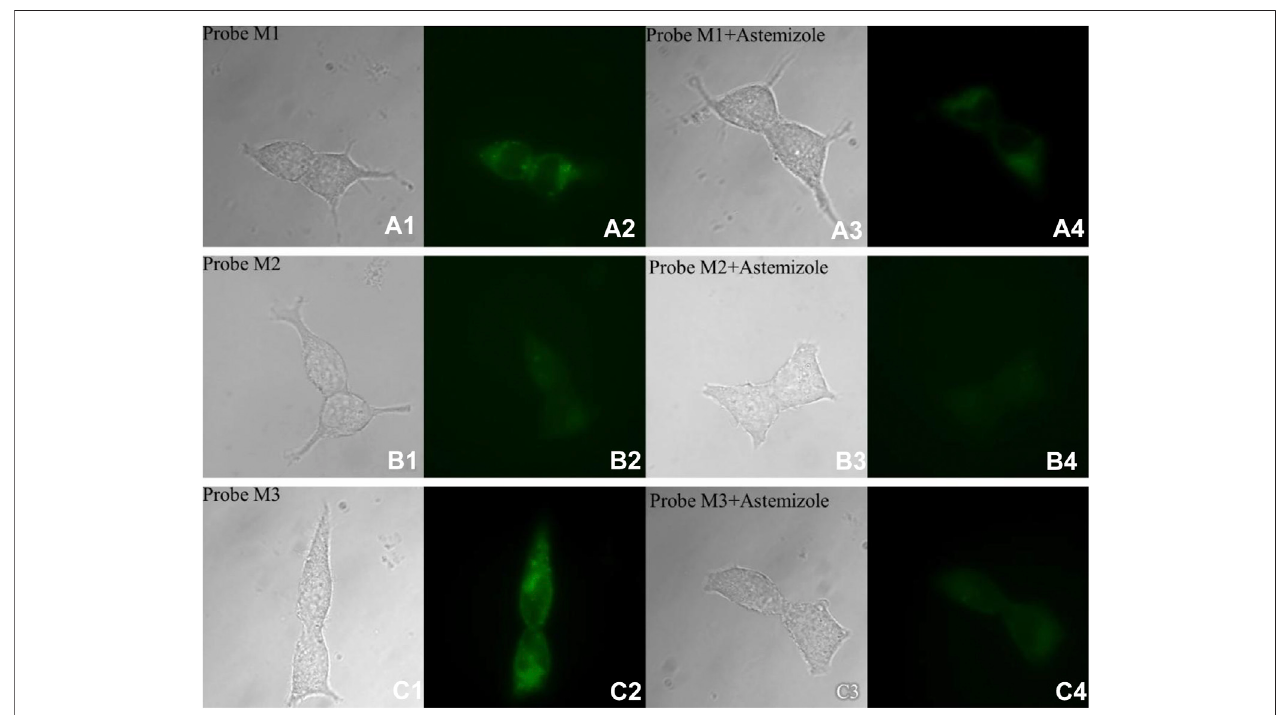
FIGURE 5 | Fluorescence microscopy imaging of hERG-transfected HEK293 cells incubated with 1.0 μ M probe M1 ( A1 : bright fi eld; A2 : GFP channel), 5.0 μ M probe M2 ( B1 : bright fi eld; B2 : GFP channel), and 5.0 μ M probe M3 ( C1 : bright fi eld; C2 : GFP channel). The imaging of inhibition of the hERG channels was accomplished byincubating astemizole (10, 50,and 50 μ M) withprobes M1 (1.0 μ M; A3 : bright fi eld; A4 :GFP channel), M2 (5.0 μ M; B3 : bright fi eld; B4 :GFPchannel), and M3 (5.0 μ M; C3 : bright fi eld; C4 : GFP channel). All cells were incubated with each probe at 37 ° C for 10 min and washed immediately. The background was adjusted by ImageJ software. Imaging was performed using a Zeiss Axio Observer A1 microscope with a × 63 objective lens. Scale bar (cid:2) 20 μ m.